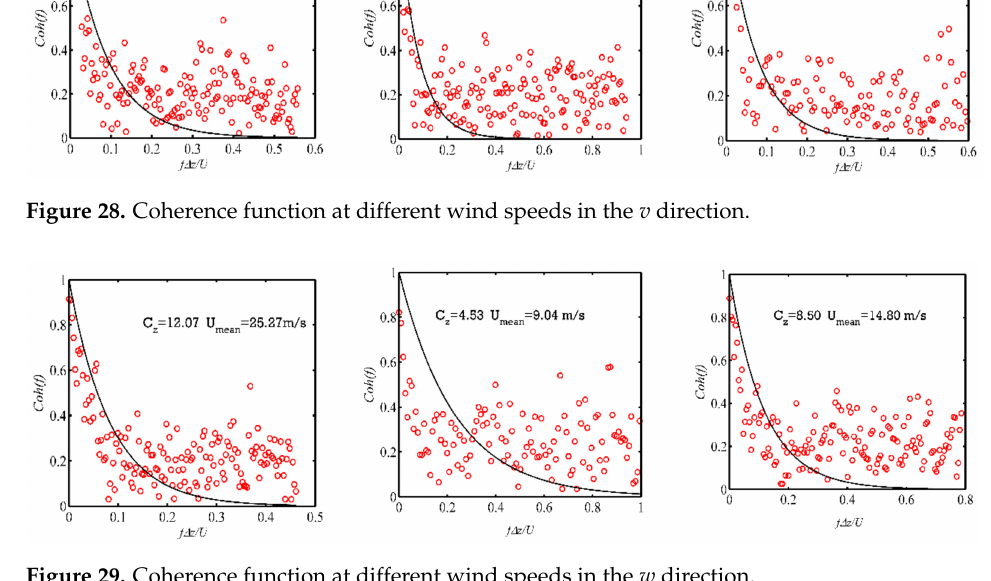
Figure 29. Coherence function at different wind speeds in the w